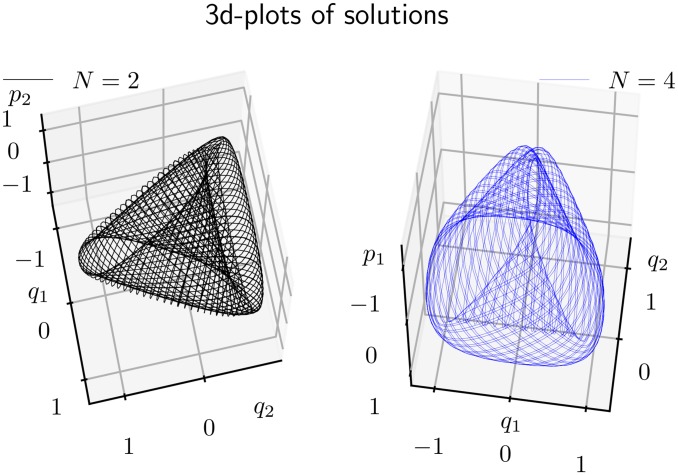
A quasi-periodic orbit z(t) for times 0 ≤ t ≤ 2000, found by the KiMoKi solvers of order N = 2 (left panel) and order N = 4 (right panel) with timestep τ = 0.1, projected to respectively the (q1, q2, p2) (left) and (q1, q2, p1) (right) subspaces.The initial condition z0 = (0.1, 0, 0.1, 1.40709), with H0 = 1, C3⊥ = −6.45412. The viewing angle is set to (ϑ, φ) = (68, 78) (left), respectively (ϑ, φ) = (−128, −8). Here ϑ is the elevation angle (elev) and φ the azimuth angle (azim).